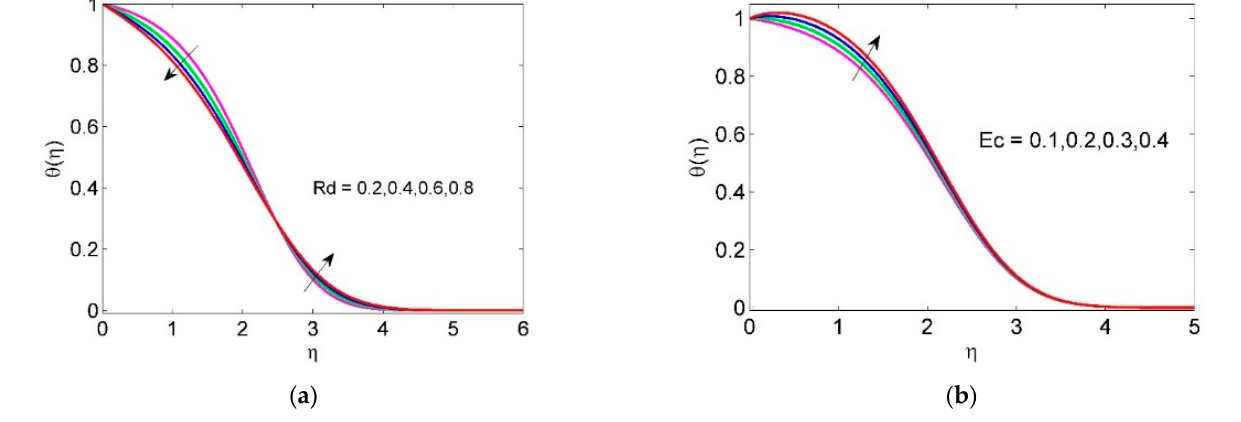
Figure 5. Impacts of Rd and Ec on 𝜃(𝜂) .